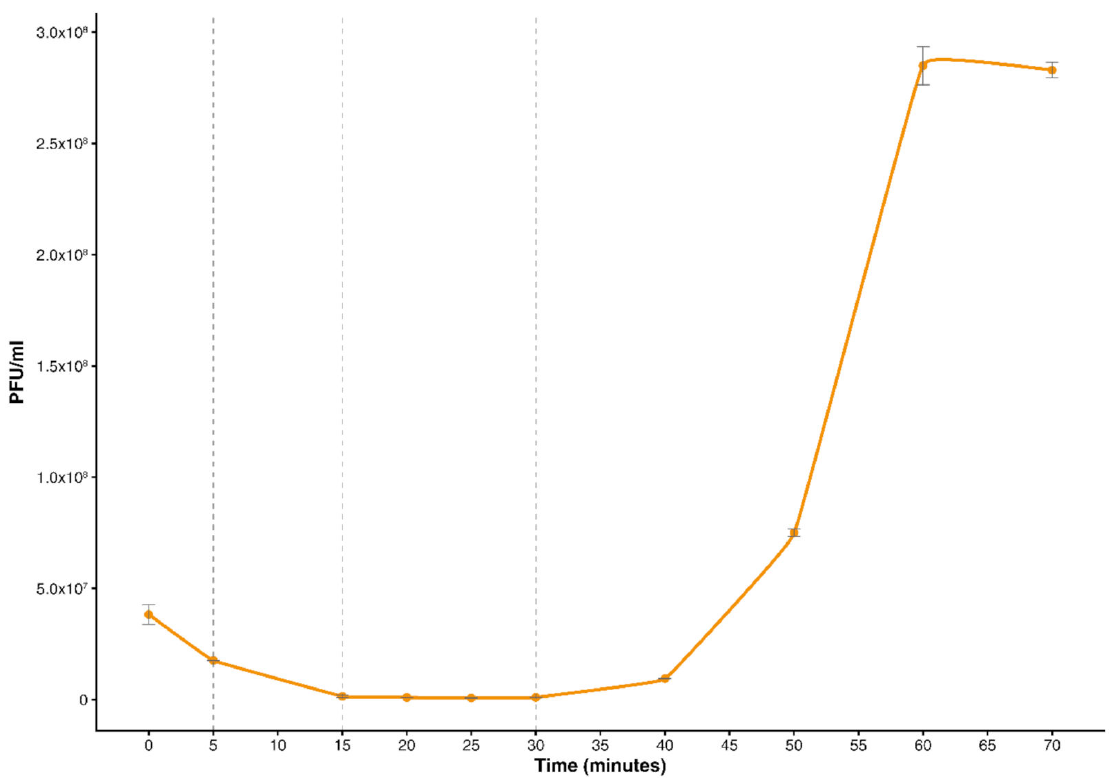
Figure 1. The one-step growth curve of vB_SauM-515A1 bacteriophage. Dotted lines indicate the three sampling time points selected for the transcriptomic